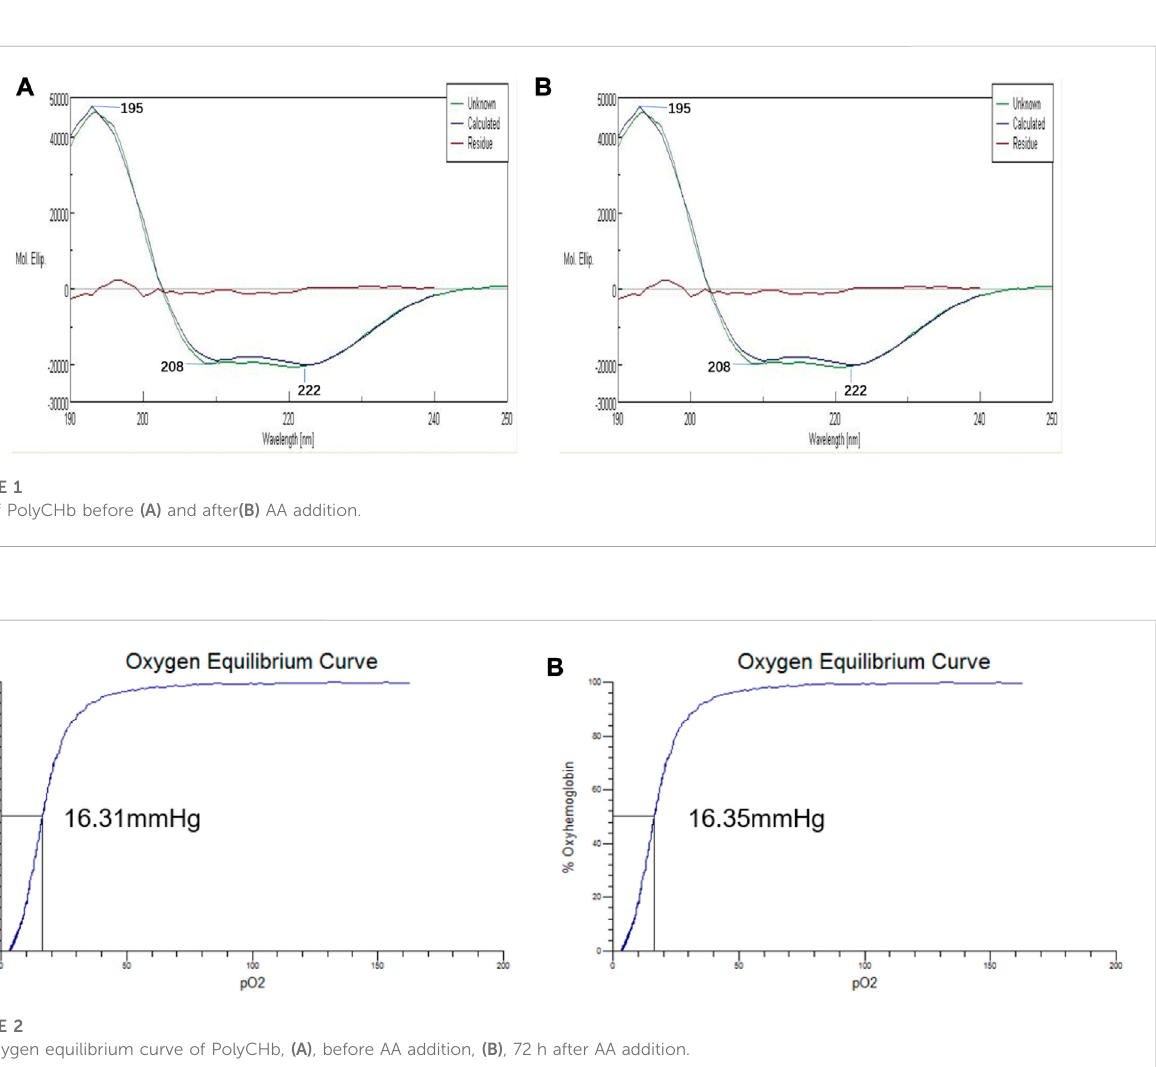
Frontiers in Bioengineering and